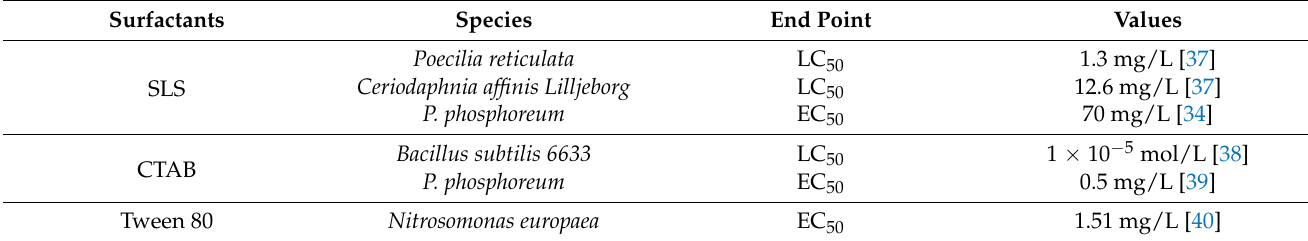
Table 2. Toxicity data of the surfactants for aquatic